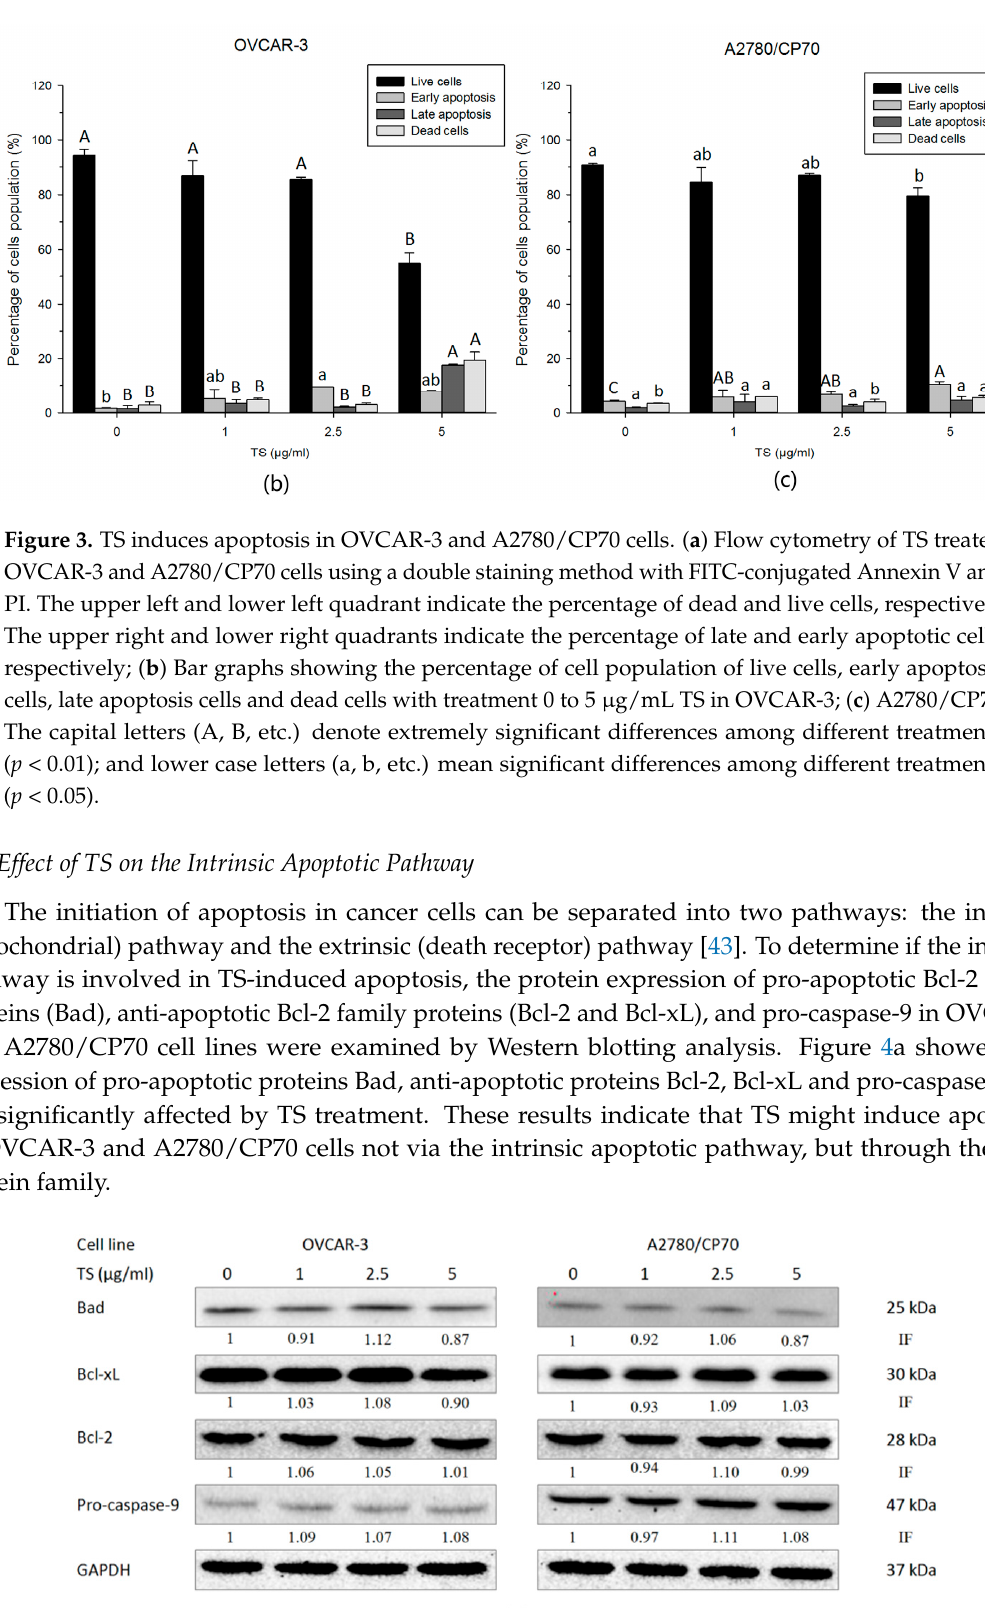
Figure 4. Effects of TS on the intrinsic apoptotic pathway and extrinsic apoptotic pathway in OVCAR- 3 and A2780/CP70 cells. ( a ) The intrinsic apoptotic pathway related protein expression levels of Bad, Bcl-2, Bcl-xL, and pro-caspase-9 with 0 to 5 µg/mL TS treatment for 24 h by Western blotting; ( b ) The extrinsic apoptotic pathway-related protein expression levels of FasL, DR5, and FADD after 0 to 5 µg/mL TS treatment for 24 h by Western blotting. “IF” means impact factor and represents the Western blotting signals were quantified and normalized to the loading control GAPDH. 2.5. TS Reduces Tumor-Induced Angiogenesis In Vitro by Downregulating VEGF and HIF-1 α A VEGF ELISA assay confirmed the reduction of VEGF in a culture supernatant form through TS treatment (Figure 5a, p < 0.05). Our results showed that TS treatments diminished the secretion of VEGF. VEGF secretion was decreased from 76.8% to 28.6% in OVCAR-3 cells and from 70.3% to 20.7% in A2780/CP70 cells when treated with 1 to 5 µg/mL of TS. Western blotting analysis revealed that TS decreased the expression of hVEGF and HIF1 α , but had no influence on the expression of HIF-1 β (Figure 5b). These results suggest that TS reduces VEGF expression through a HIF1 α -dependent pathway rather than through an HIF-1 β pathway.